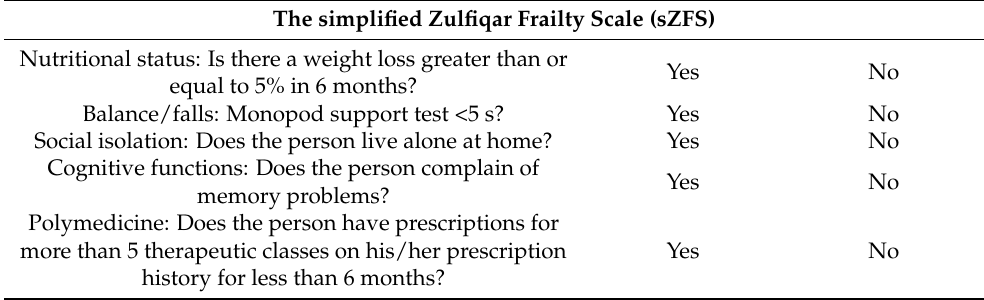
Table 1. The simplified Zulfiqar Frailty Scale (sZFS). The simplified Zulfiqar Frailty Scale (sZFS)